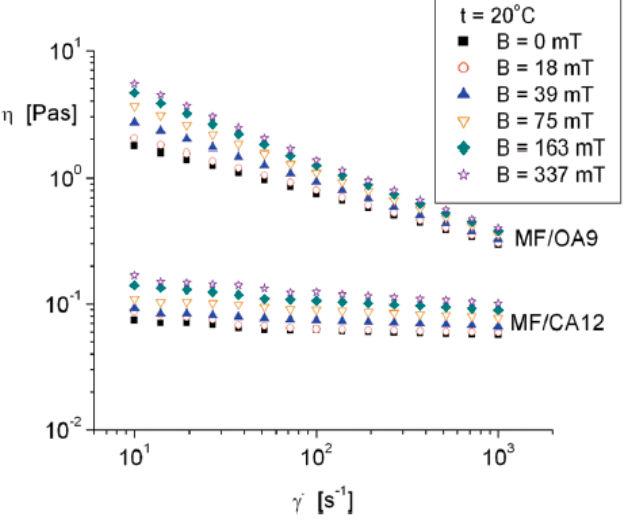
Figure 20. Viscosity curves at different magnetic flux densities for the highest concentration samples: MF/CA12 (physical vol fraction 20%) and MF/OA9 (physical vol fraction 14%). Reproduced from Reference [85] with permission from The Royal Society of Chemistry.